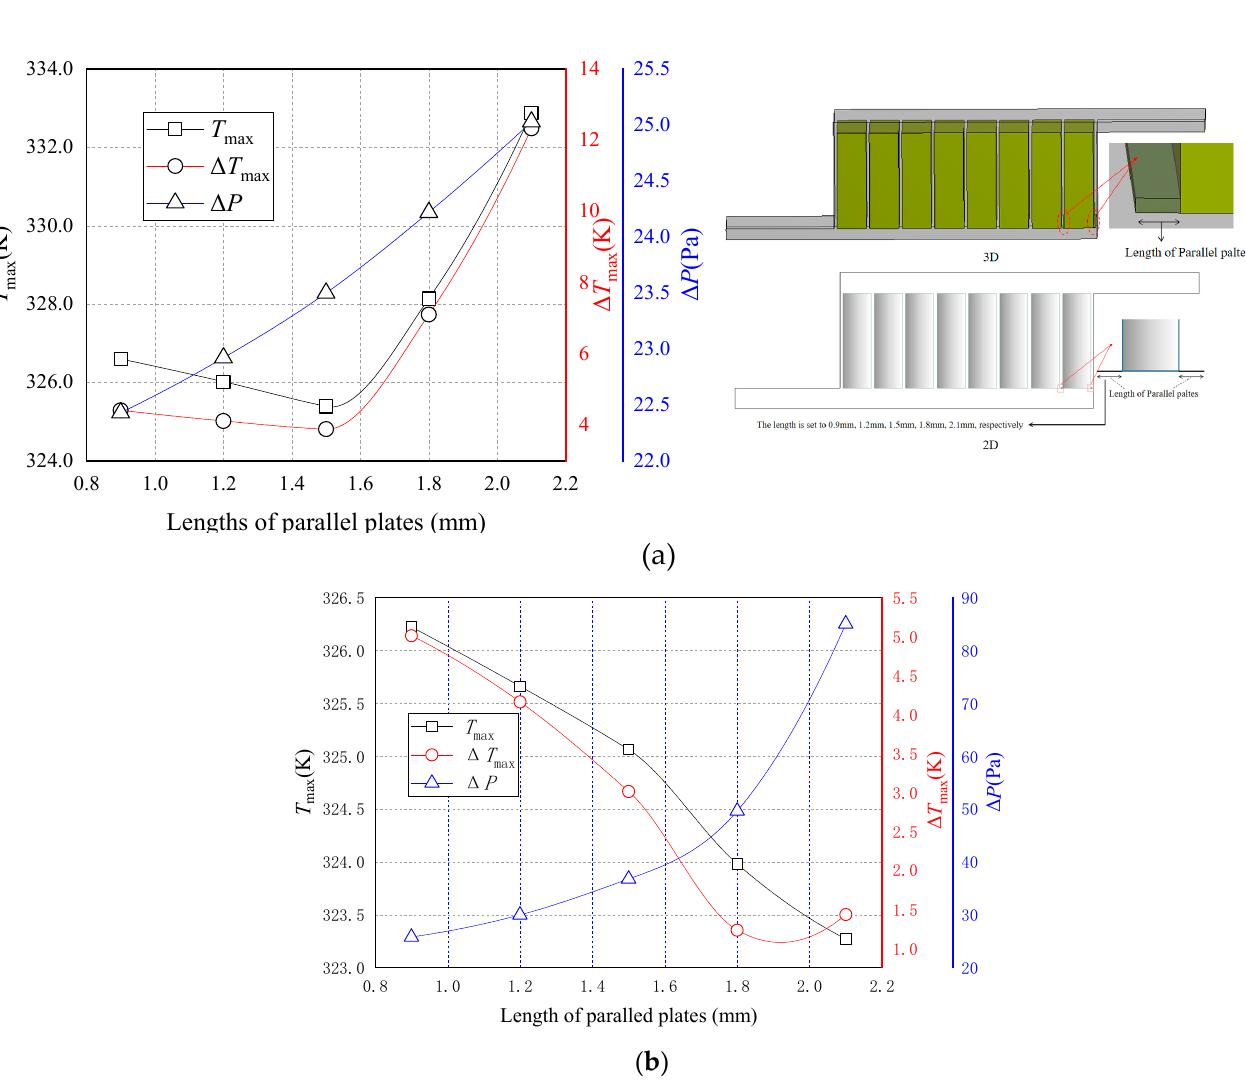
Figure 10. T max , Δ T max , and Δ P of the battery pack under various lengths of parallel plates; ( a ) cooling performance in case2 under various lengths of parallel plates; ( b ) cooling performance in case9 under various lengths of parallel plates.